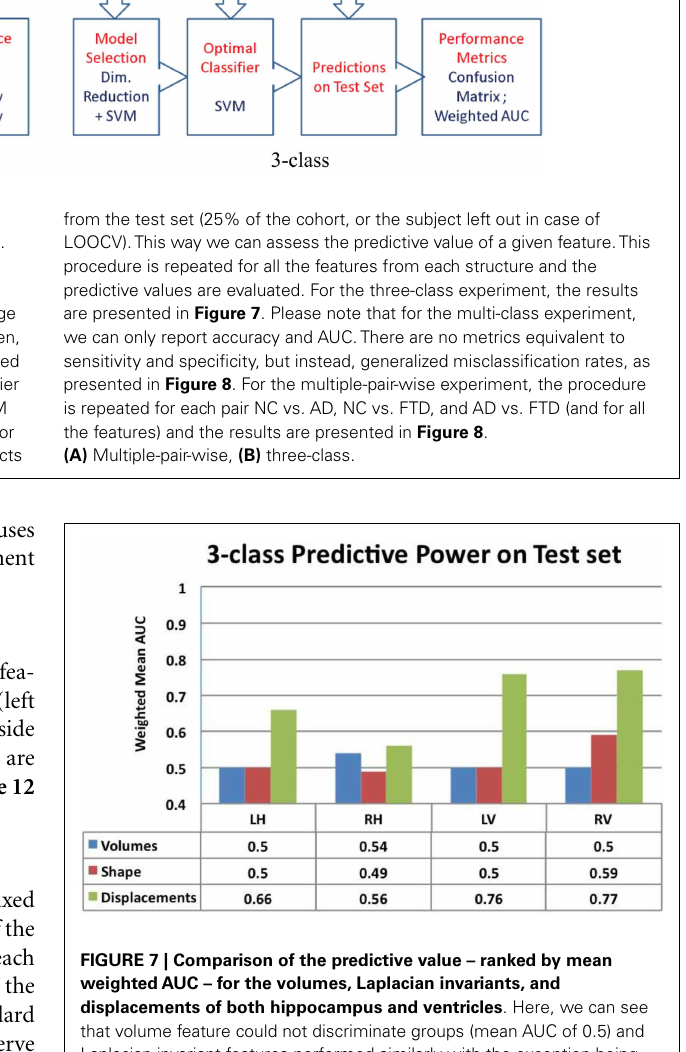
FIGURE 7 | Comparison of the predictive value – ranked by mean weightedAUC – for the volumes, Laplacian invariants, and displacements of both hippocampus and ventricles . Here, we can see that volume feature could not discriminate groups (mean AUC of 0.5) and Laplacian invariant features performed similarly with the exception being right lateral ventricle, whose performance is slightly better than that expected by chance.The predictive value of displacements is superior to that of volumes and invariants, indicating their potential in providing differential discrimination between AD, FTD, and NC. L, left; R, right, H, hippocampus, andV,